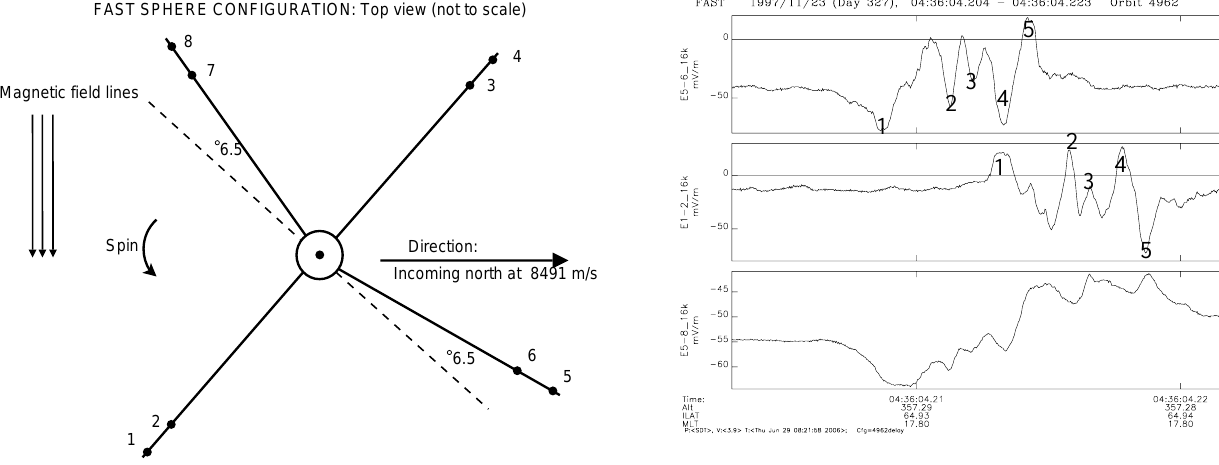
Fig. 3. Left panel: A schematic view of the electric field sensors on the FAST satellite at 4.21s past 04:36UT. The EIC-like oscillations of this time are seen on the right panel. Right panel: High-resolution electric field waveforms of the sensors V5-6, V1-2, and V5-8. The numbering 1 to 5 identifies spikes that can be matched (after sign reversal) from V5-6 signal to V1-2 after a time delay of approximately